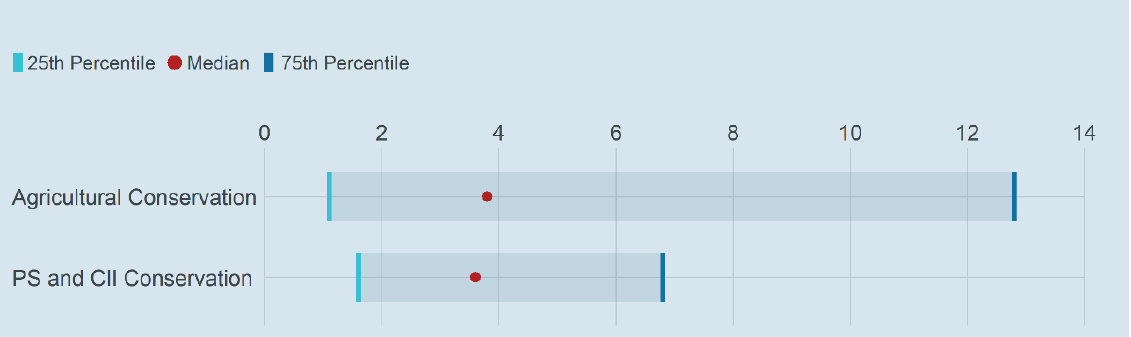
Figure 6. Estimated Project Expenditures per Unit of Capacity for Water Conservation Projects (million USD 2021 per MCM). Data source: 2020 Annual Status Report on Regional Water Supply Planning, Florida Department of Environmental Protection (DEP) [6].